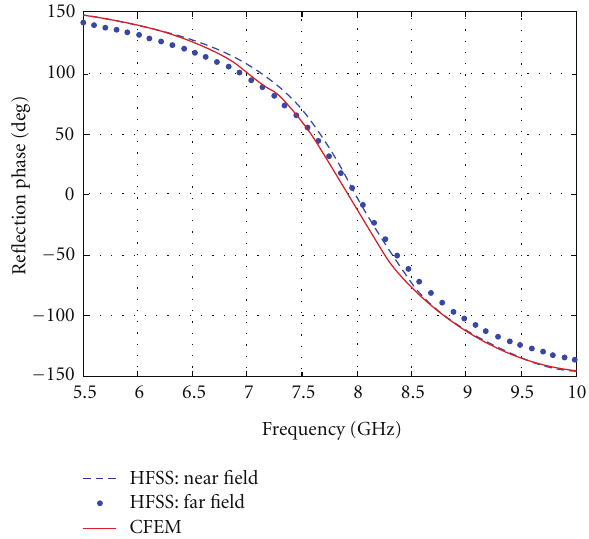
Figure 8: CFEM convergence for the square patch AMC in Figure 6. Reflection phase angle at normal incidence ( θ = 180 ◦ ) is shown for di ff erent CFEM modes and HFSS methods. Substrate thickness is 0 . 5mm. “tet”represents the number of tetrahedrons.